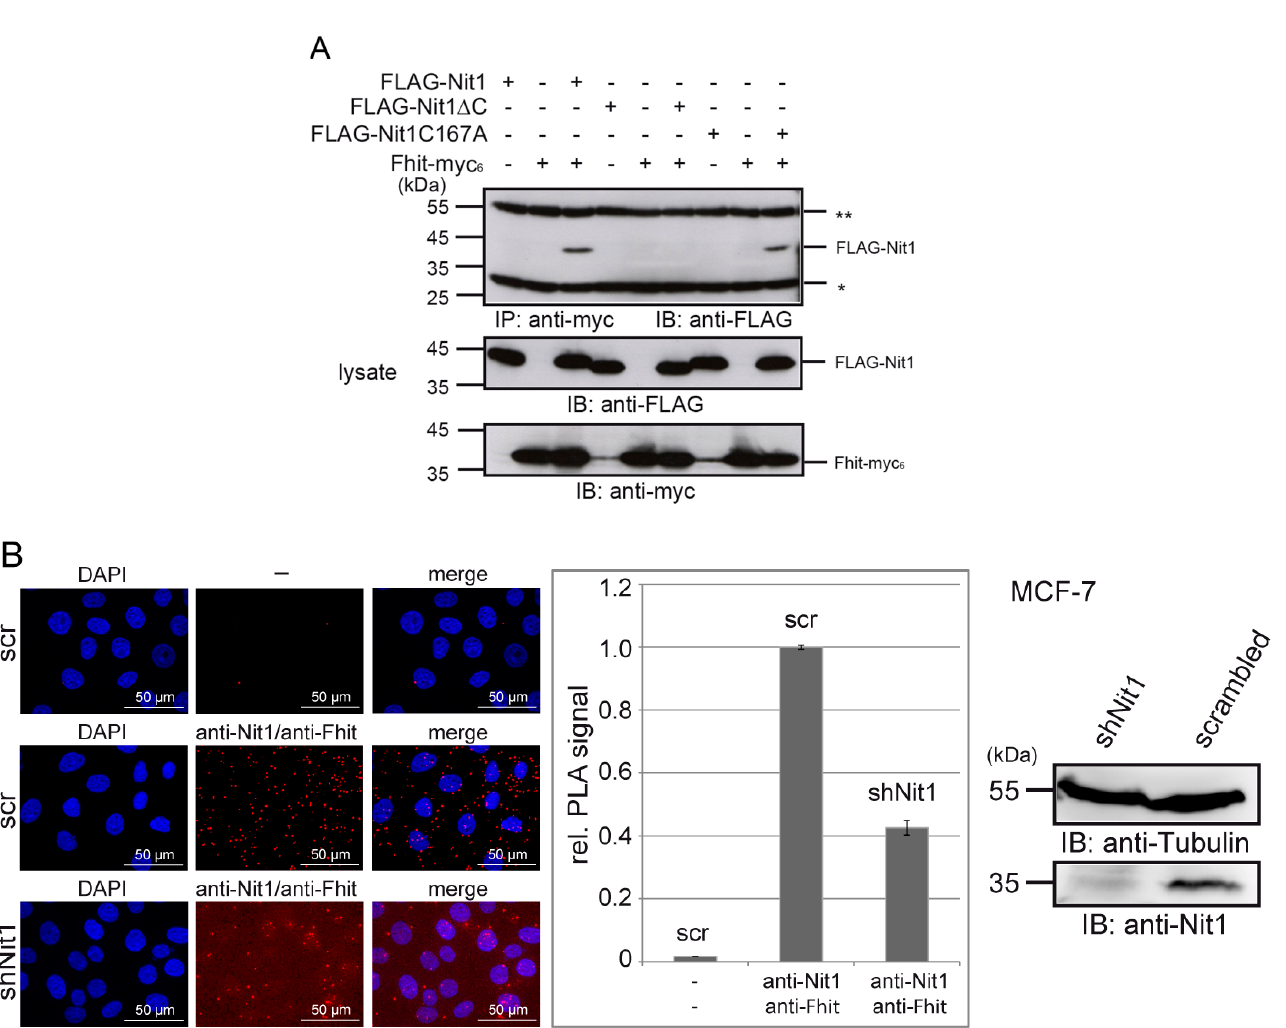
Figure 4. Nit1 associates with Fhit. ( A ) HEK-293 cells were transiently transfected with FLAG-Nit1 variants in combination with Fhit-myc 6 as indicated. Fhit was precipitated with anti-myc (9E10) antibody and co-precipitated proteins were visualized by SDS-PAGE and Western blot analyses with anti-FLAG antibody. Lysate controls are shown in the lower panels. The illustrated Western blot is an example of at least three independent experiments. * light chain and ** heavy chain of precipitating antibody. ( B ) Duolink ® proximity ligation assays in MCF-7 cells stably transfected with scrambled or Nit1 shRNA were performed with mouse anti-Fhit and rabbit anti-Nit1 antibodies. Secondary antibody control (-) is shown in the upper part. Quantification of three independent experiments with Fiji Open Source software is presented in the bar diagram. Knock-down of Nit1 as determined by Western blotting is depicted on the right side.